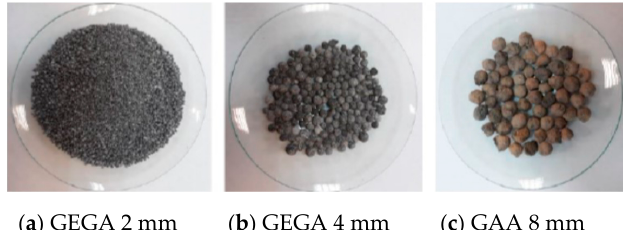
Figure 1. Aggregates: ( a , b ) granulated expanded glass aggregate (GEGA), ( c ) granulated ash aggregate (GAA).